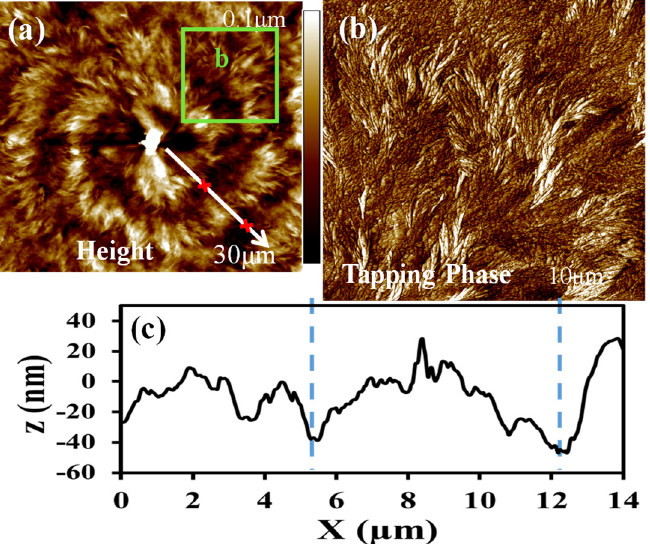
Figure 4. ( a ) AFM height images of the nucleus region of dendritic/ringed spherulites of PPDO/PVPh (75/25) blend crystallized at T c = 78 °C, and ( b ) height profile along the radial direction [white arrow in Graph-( a ): radial direction.], ( c ) height profile showing inter-band spacing=ca. 6 μ m. Figure 5a,b show integrated AFM height and phase images for PPDO/PVPh = 75/25 crystallized at T c = 78 °C (solvent-etched). AFM analysis provides better height profiles and image zoom-in than POM. The AFM results display that individual rings are formed along a lengthwise direction of the arm-finger branches of the banded dendritic